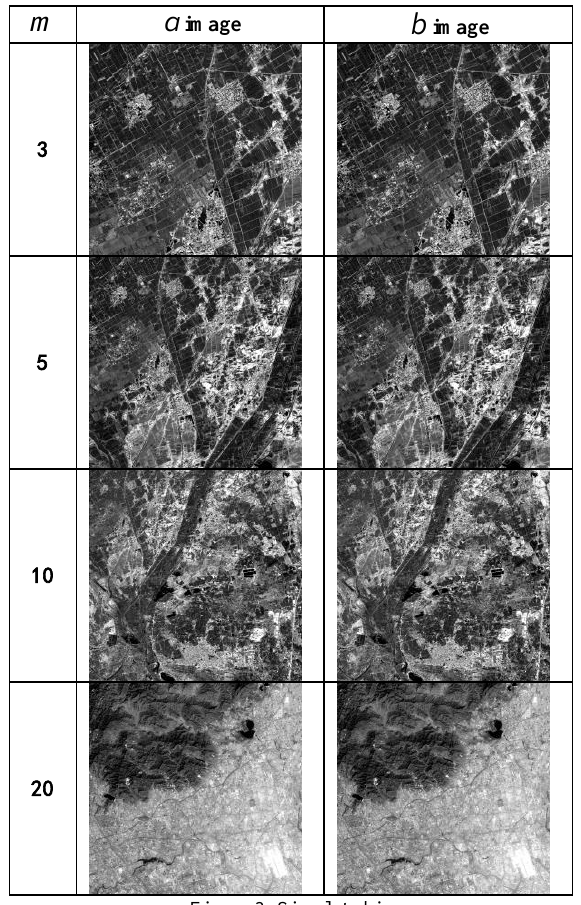
Figure 3. Simulated images